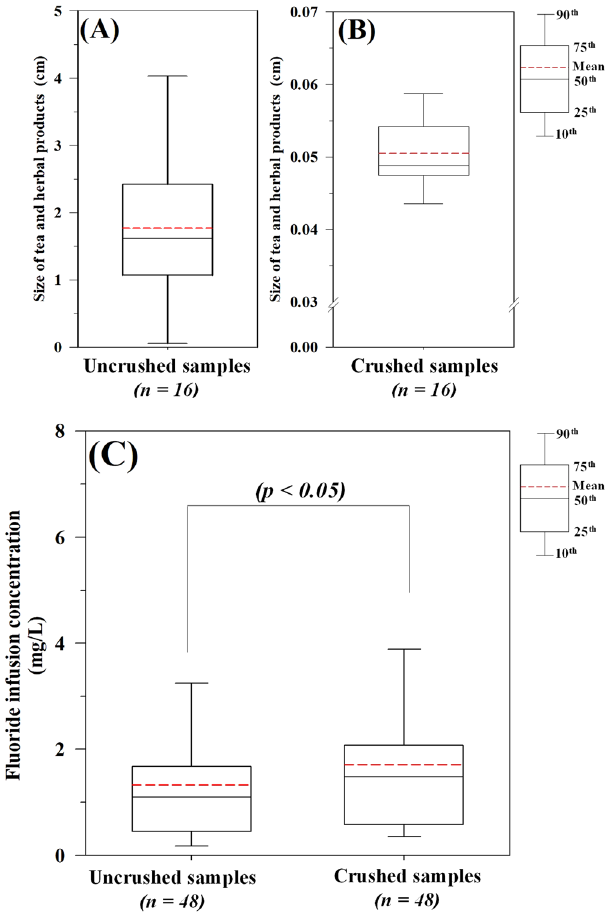
Figure 2. Influence of leaf size of tea and herbal products on fluoride concentration during infusion. Particle sizes of the ( A ) uncrushed and ( B ) crushed tea samples. ( C ) Comparison of infusible fluoride concentrations between the uncrushed and crushed tea